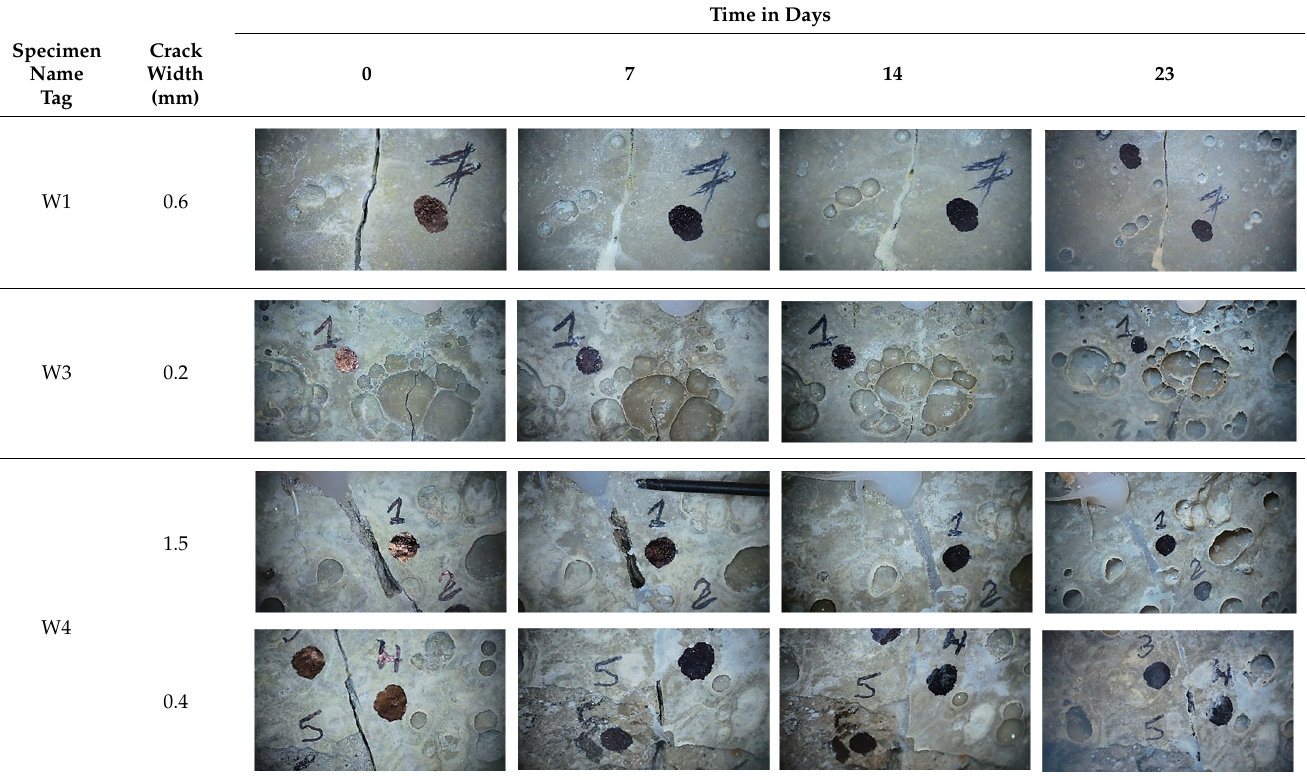
Table 15. Image compilation for self-healing evaluation for intrinsic approach. Time in Days